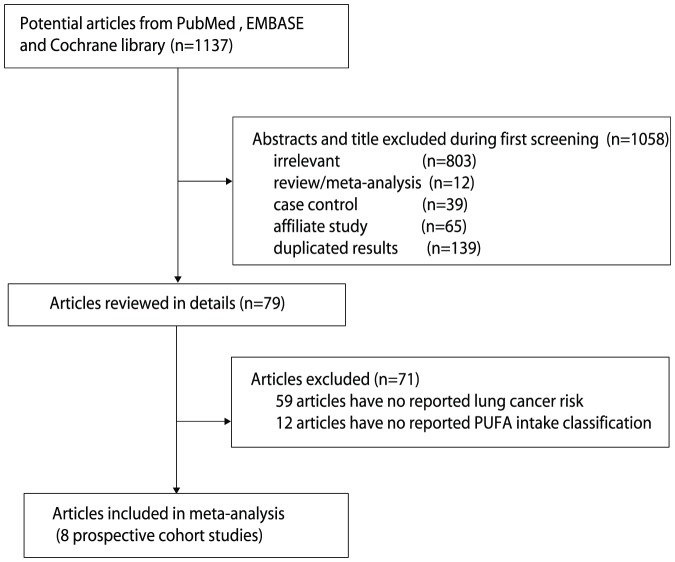
Flow diagram of the literature search and studies selection process.